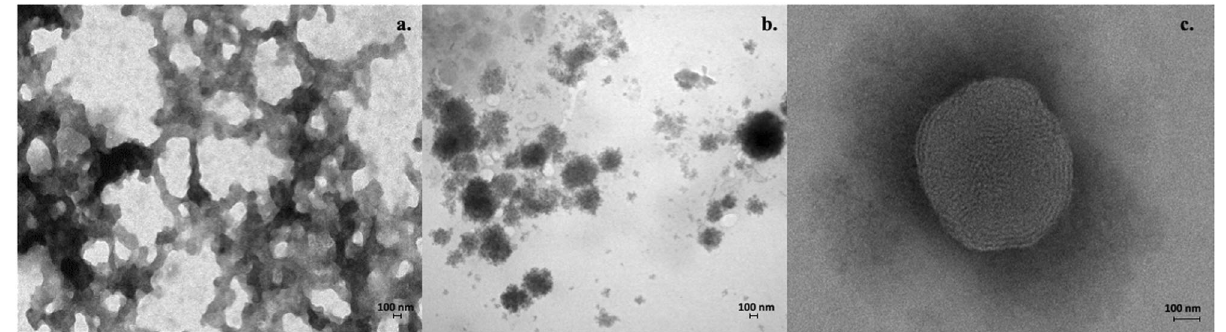
Fig. 3 TEM of ( a ) polymer solution, ( b ) formulation P3 and ( c ) formulation P4